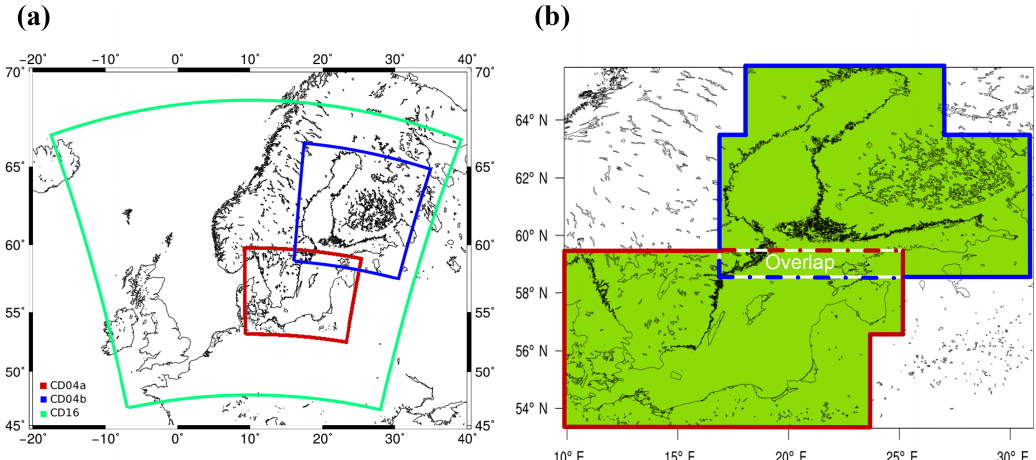
Figure 1. Model nests used in the simulations with CMAQ and for the spatial maps of model results: (a) computational grid for northern Europe with 16 × 16km 2 resolution (CD16, green) and the high-resolution grids of 4 × 4km 2 for southern Baltic Sea (CD04a, dark red) and northern Baltic Sea (CD04b, dark blue). (b) Exemplary structure of spatial maps spanning from latitude 53.30 ◦ N (southern border) to 65.80 ◦ N (northern border) and longitude 9.85 ◦ E (western border) to 30.95 ◦ E (eastern border). Green shaded area is the high-resolution area which shows output from regional model runs with a grid resolution of 4 × 4km 2 . Dark red outline marks the extent of the southern part of the Baltic Sea region and dark blue outline marks the extent of the northern part of the Baltic Sea region, for which model output from two high-resolution nests were used. For the overlap area, the arithmetic mean of results from both nests was used. In the post-processing of model results, the native Lambert conformal projection of CMAQ output was transformed to a regular lat–long grid; therefore the two outlined areas do not fill complete rectangles. The entire domain shown in panel (b) was interpolated to a uniform resolution of 0.05 ◦ in the post-processing. White areas of the map are covered by the output from the model nest with 16 × 16km 2 resolution.